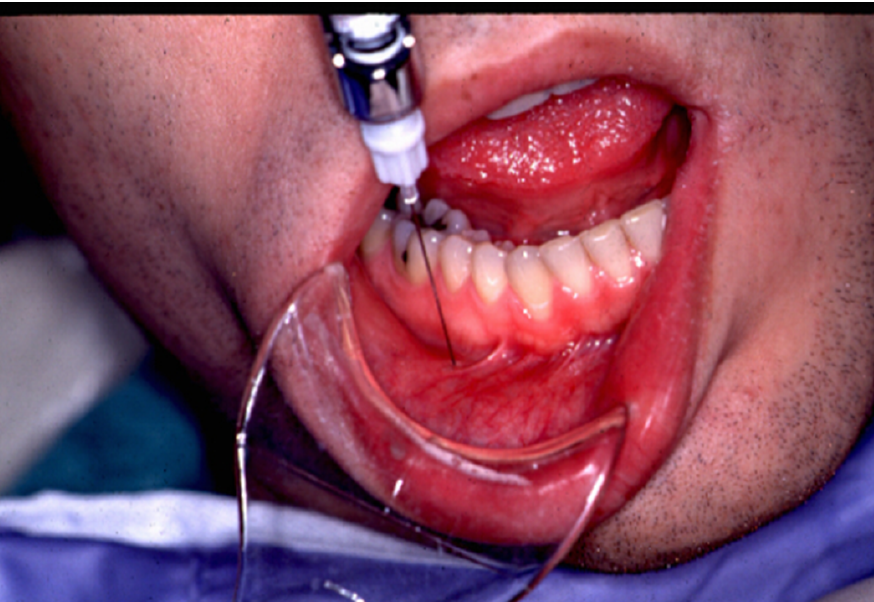
Figure 1. The technique demonstrated is used to locate the mental foramen and deposit a small amount of local anesthetic followed by Botulinum toxin type A as a treatment for trigeminal